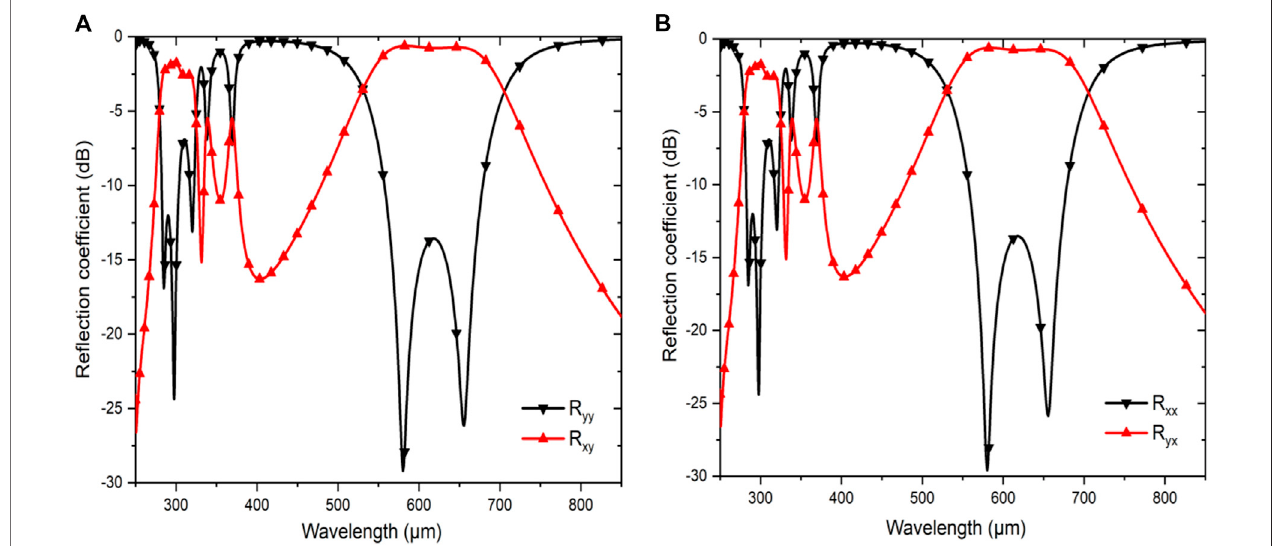
FIGURE 3 | Simulated co- and cross-polarized re fl ectance coef fi cients for (A) y-polarized and (B) x-polarized waves.